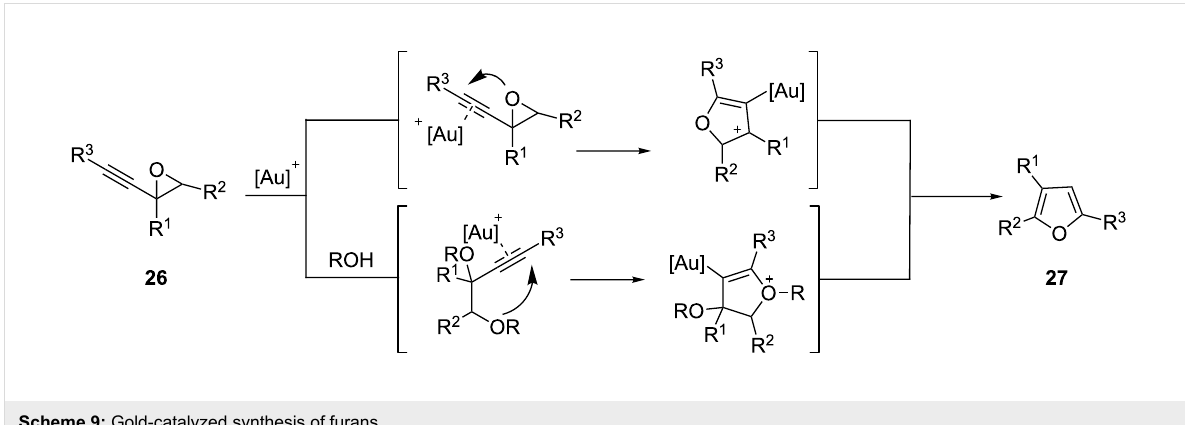
Scheme 9: Gold-catalyzed synthesis of